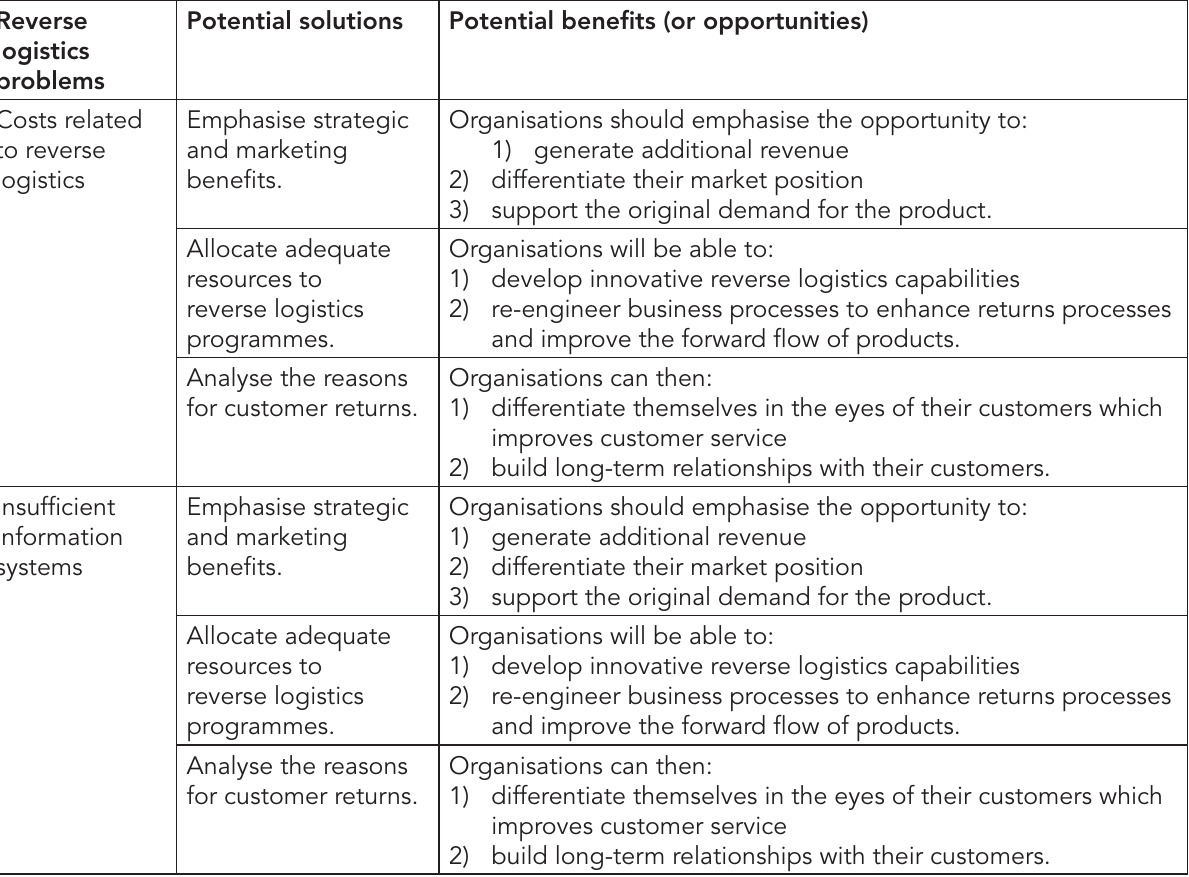
Table 1: Reverse logistics problems and potential